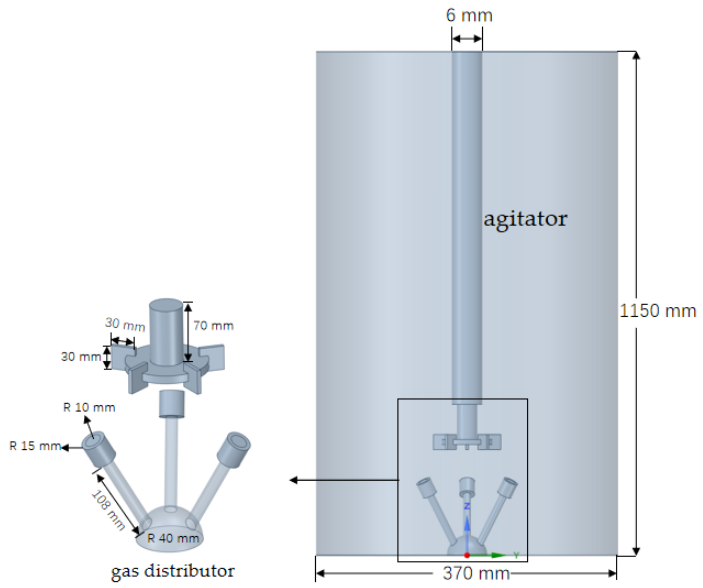
Table 1. Reactor size parameter.